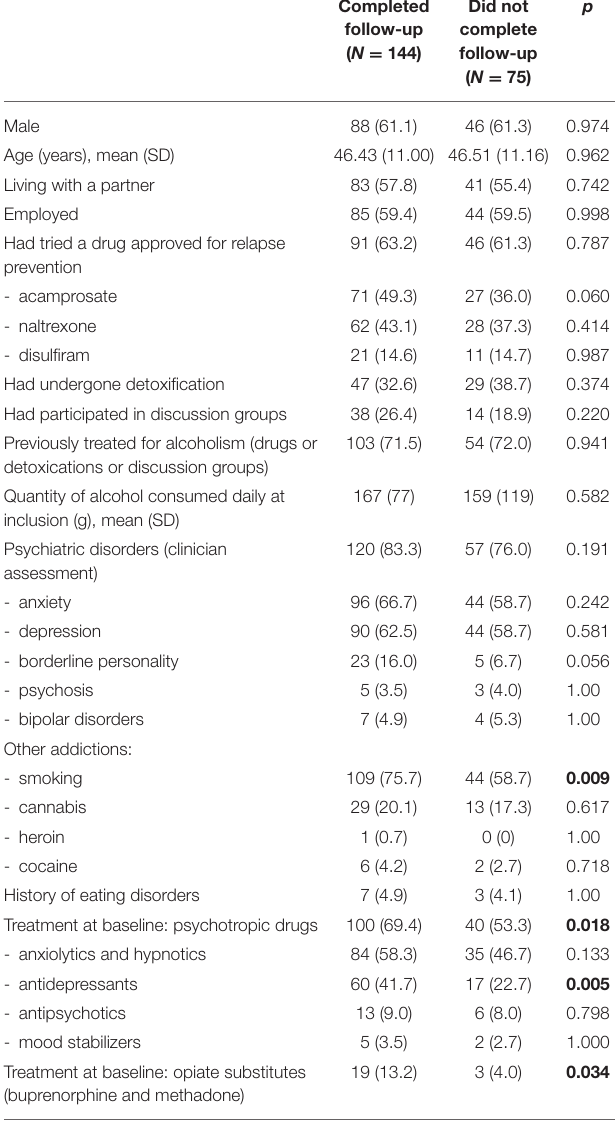
TABLE 1 | Baseline characteristics of patients who completed and did not complete follow-up at 3 years (lost to follow-up or died). Completed